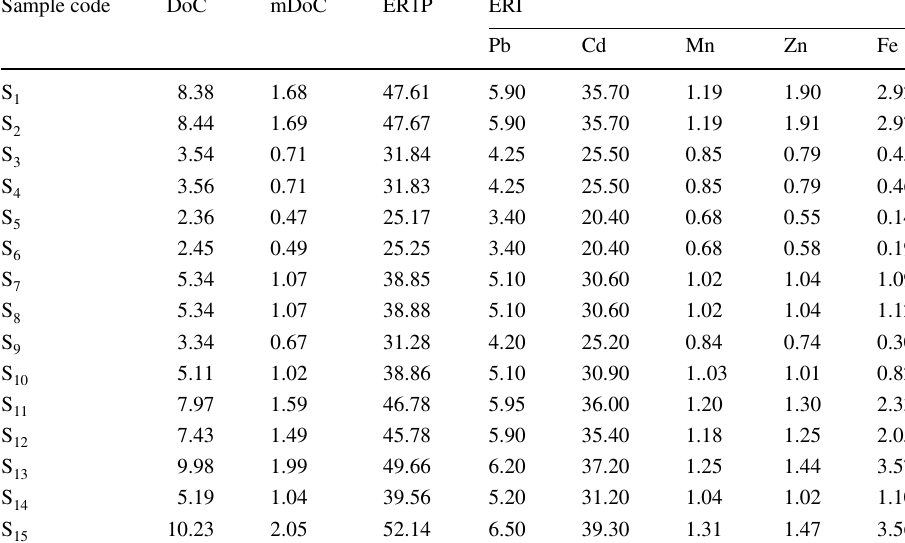
Table 13 lists the contribution of the assessed metals to the computation of HIs for the populace in the investigated residential sites. From Table 13, it was noticed that Cd and Pb have highest input to HI when compared to other assessed metals. It is worth noting that Cd played a significant role in the study area’s non-carcinogenic risk assessment (see Table 13). The HI contribution of the analyzed HMs reduced in the order: Cd > Pb > Zn > Fe > Mn.